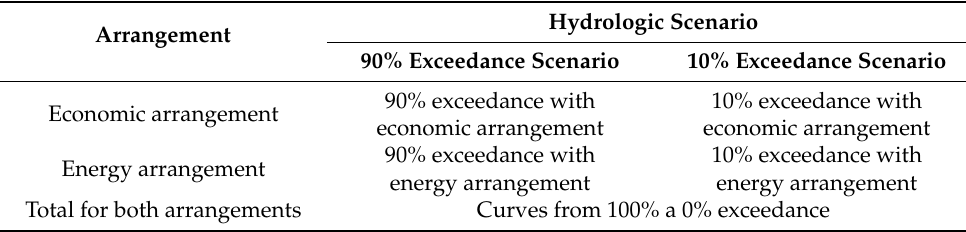
Table 1. Results presented in different hydrologic scenarios and